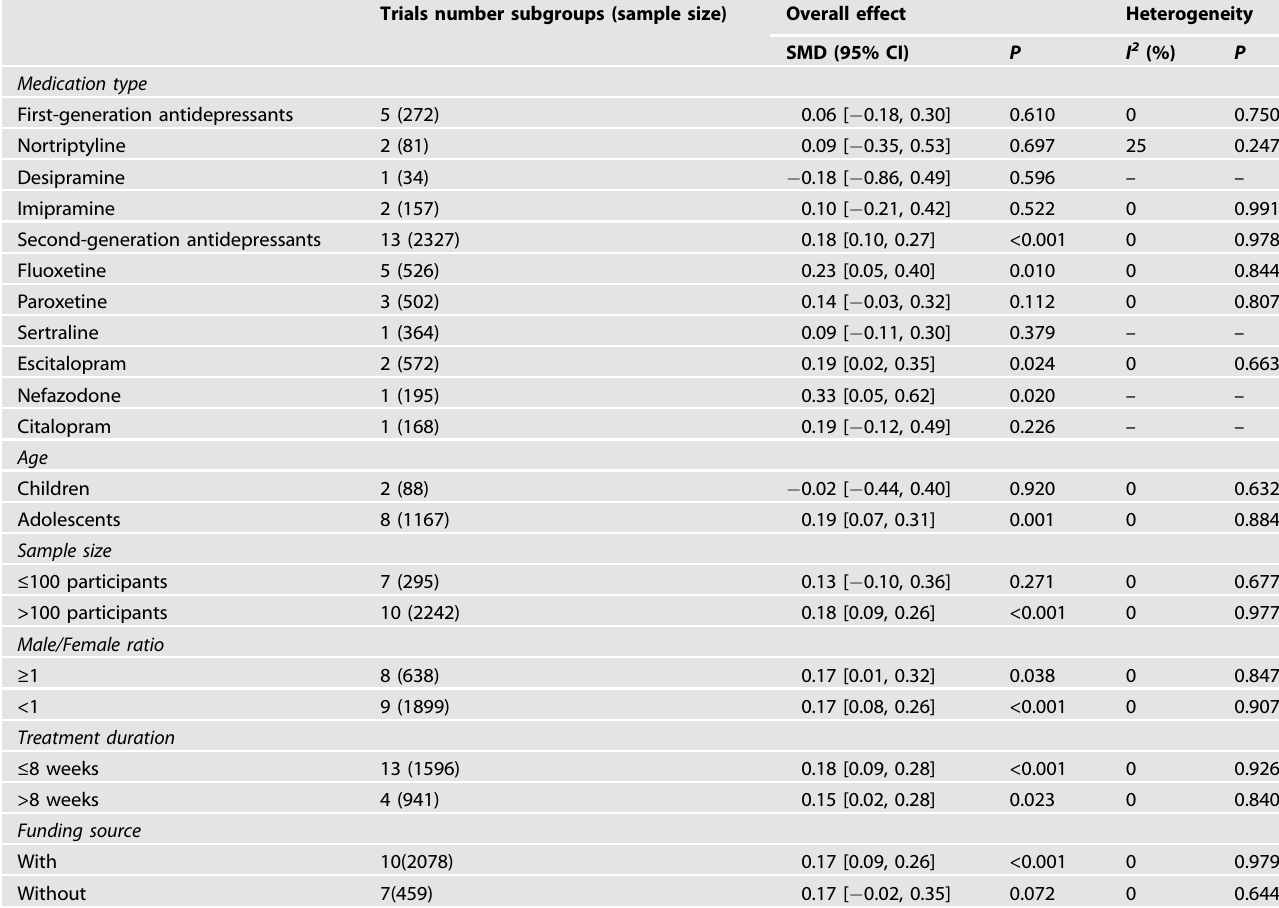
Table 2. Subgroup analyses for the primary outcome of